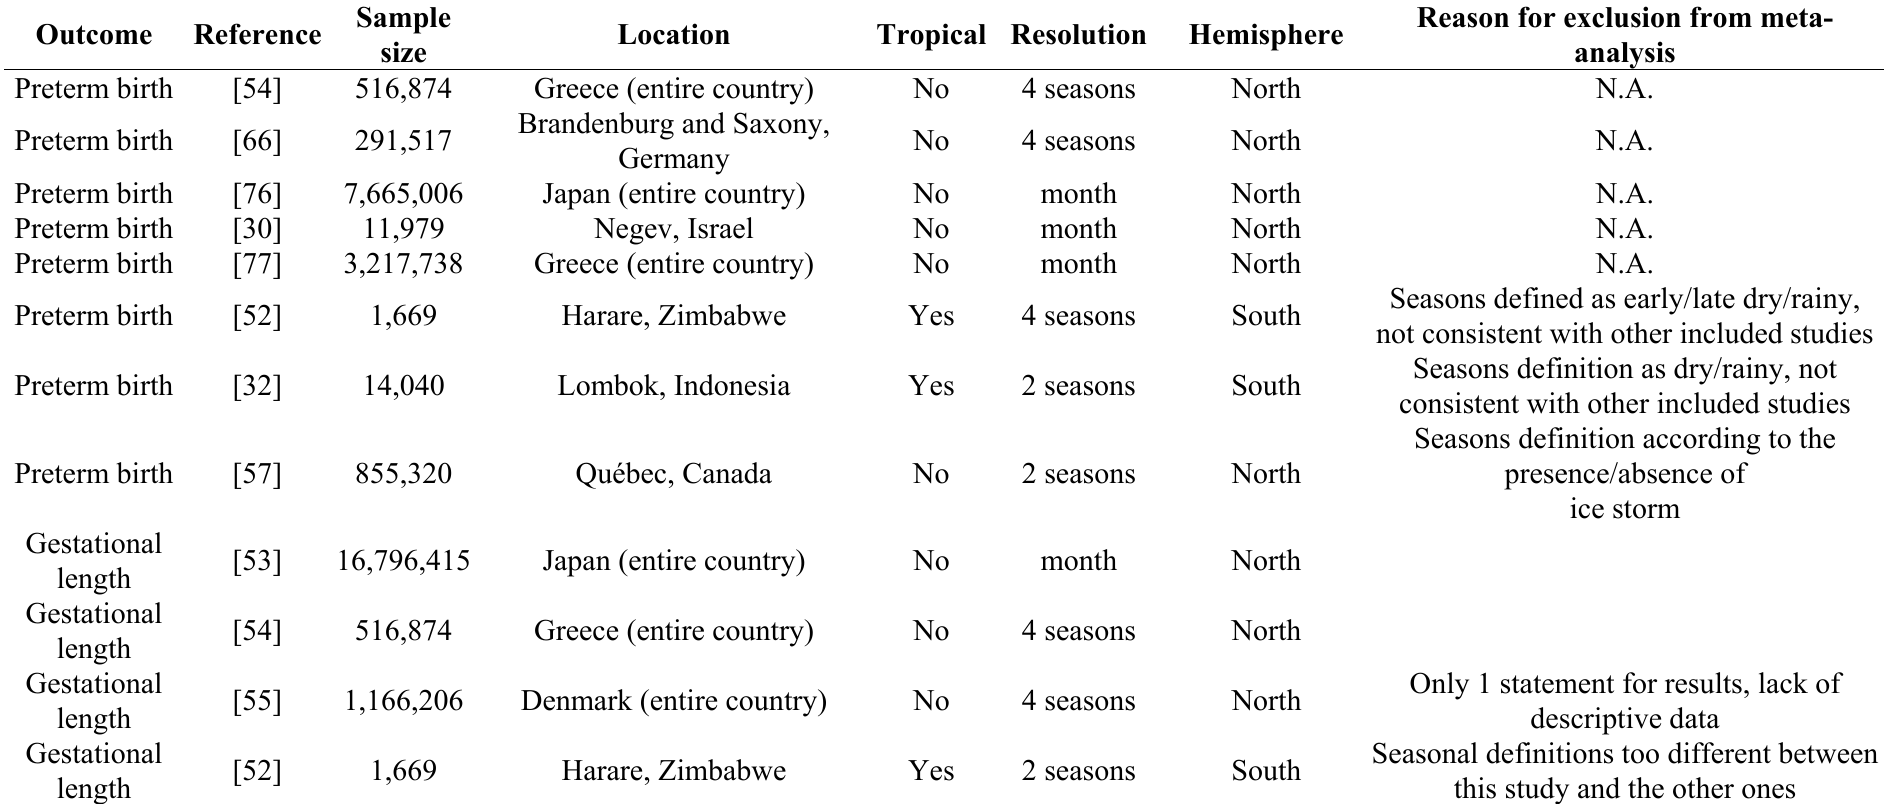
Table A18. Studies examined for the meta analysis of the influence of season of birth on preterm birth or gestational